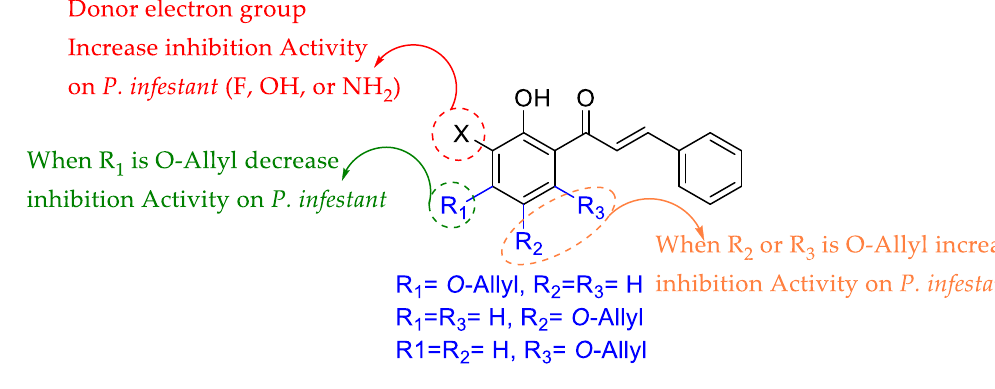
Figure 1. Summary of QSAR analysis.